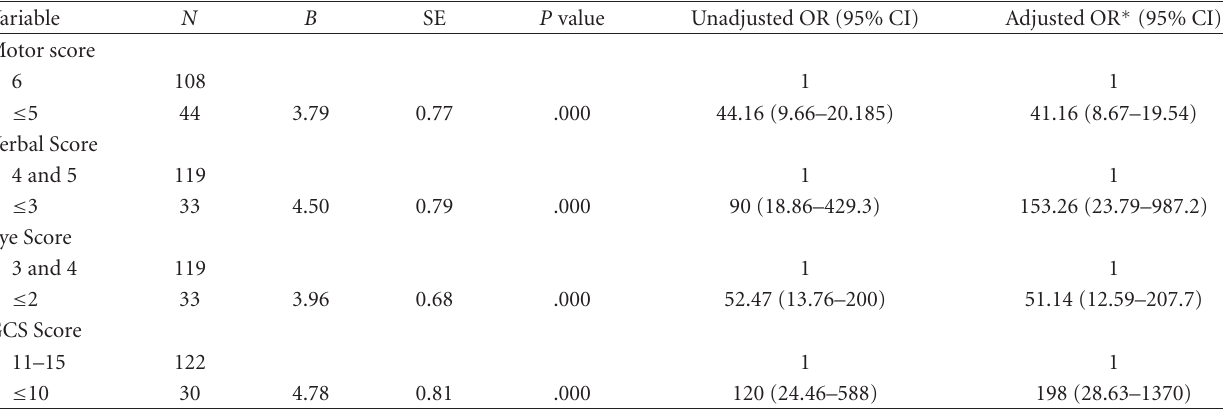
Table 5: Prediction of outcomes in patients with